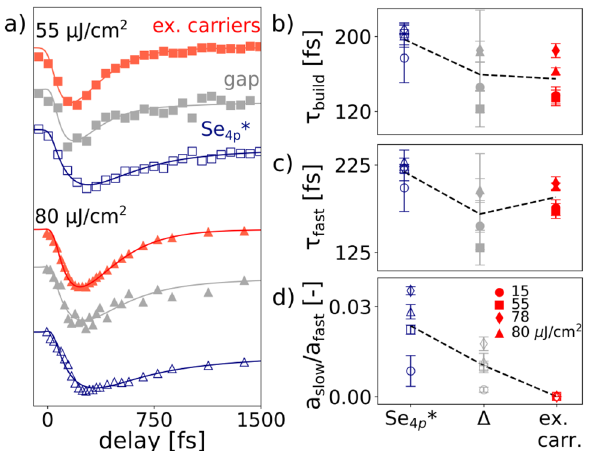
Figure 4. ( a ) Comparison of the dynamics of Se 4 p * intensity (blue empty markers), excited carriers (red solid markers) and gap (grey solid markers) for two selected fluences. For clarity the excited carrier dynamics is flipped upside down. ( b – d ) Extracted fitting parameters τ build ( b ), τ fast ( c ) and a slow / a fast ( d ) of excited carriers, Se 4 p * band intensity and gap for various fluences. Black dashed lines connect the values averaged over all fluences and serve as guide to the